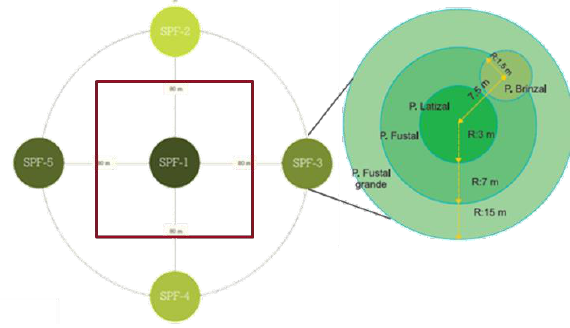
Figure 2. Structure of plots and 1-ha square